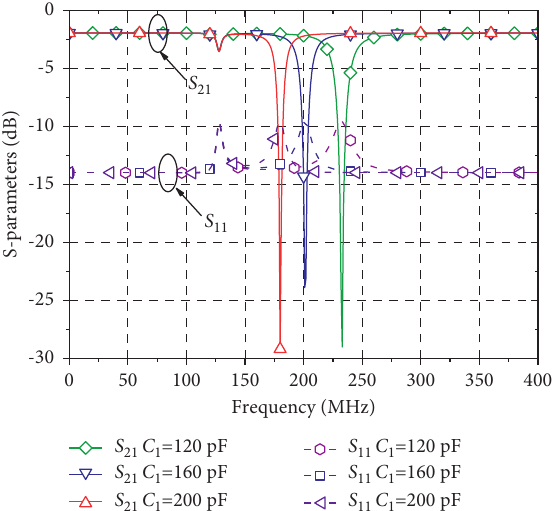
Figure 10: S parameters of the band-stop filter with band-pass negative delay at different C